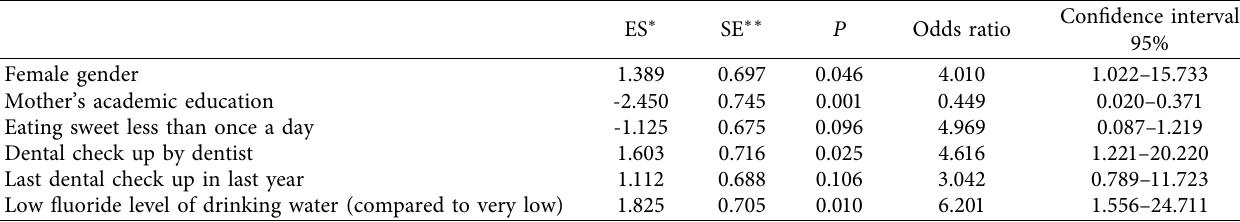
Table 4: Association of independent variables (including genotype of ENAM gene) with the caries status in the control group (caries free) compared to case group (DMFT ≥